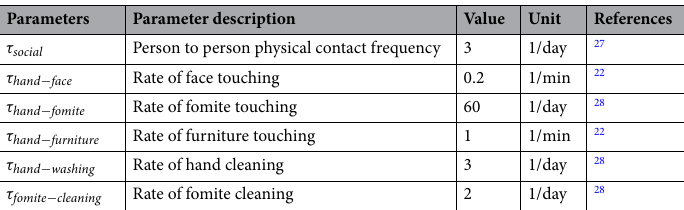
Table 1. The hygienic and behavioral parameters of the reference